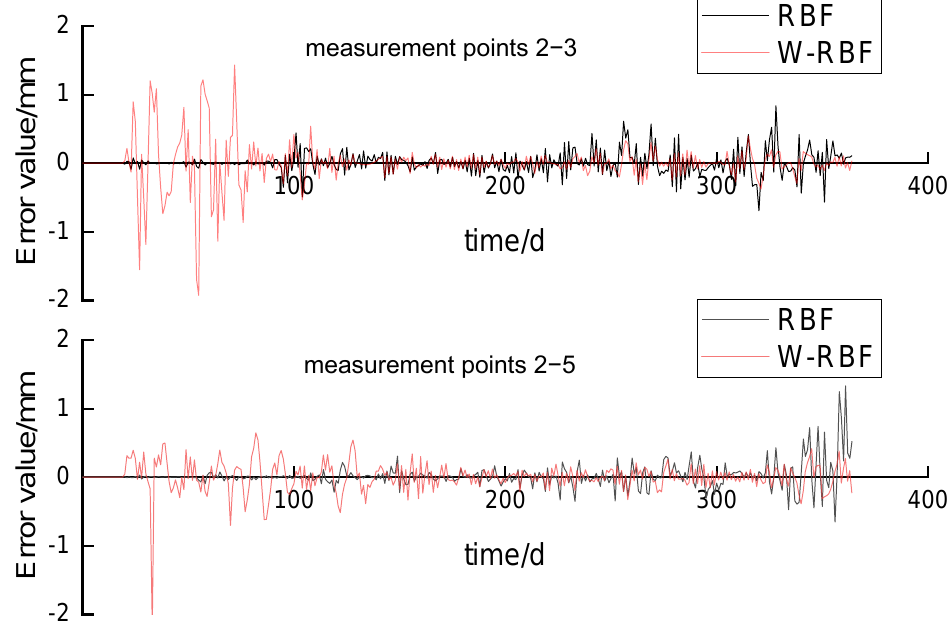
Figure 8. Comparison of error curves at points 2 − 3 and points 2 − 5.